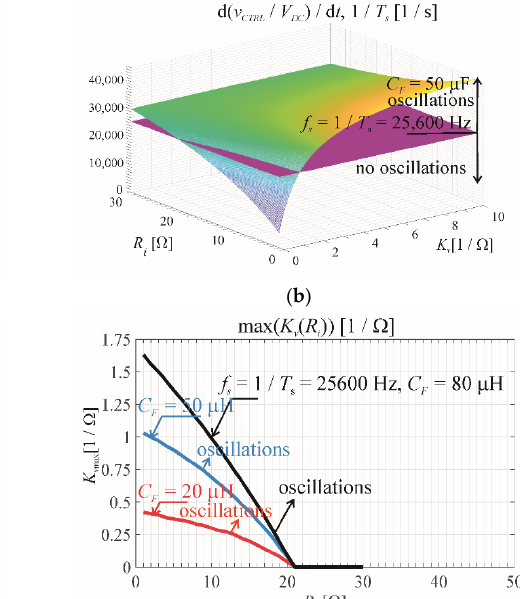
Figure 3. Determining the border gains ( d ) of the IPBC controller for a constant switching frequency f s = 25,600 Hz and different inductances L F (0.5 ( a ), 1.0 ( b ), 2 mH ( c )) when C F = 50 μ F, R LF = 1 Ω , and M = 0.5.